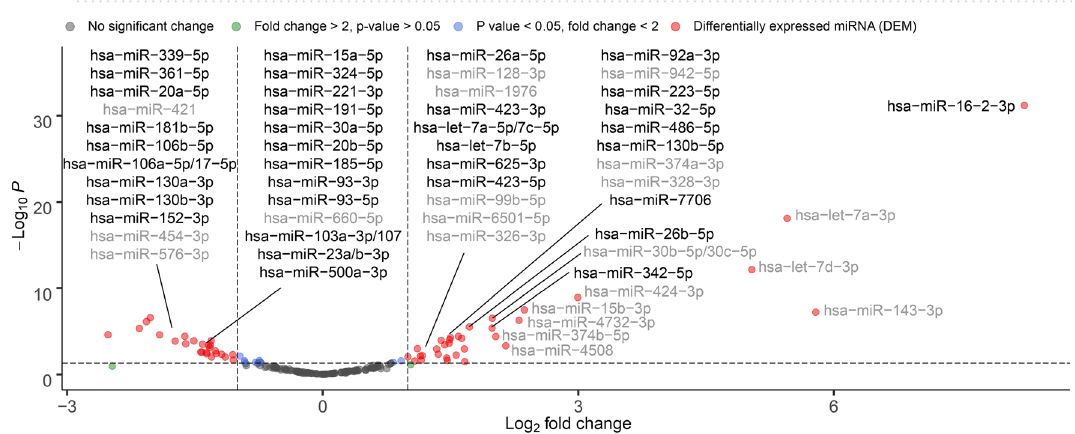
Figure 2. Results of differential expression analysis of the 190 conserved miRNAs by comparing HO patients with (HO-proven, HO-probable) or without (HO-possible) IA. Volcano plot represents the DEMs showing statistically significant overexpression and underexpression (according to the log 2 -transformed fold change in relation to the -log 10- transformed P-value). The dashed line on the y-axis indicates the P-value = 0.05 threshold with statistically significant ( P < 0.05) gene expression (up- and downregulation, respectively). Red circles indicate DEMs. Highlighted DEMs represent IA-specific miRNAs whose gene expression was not influenced by hematological